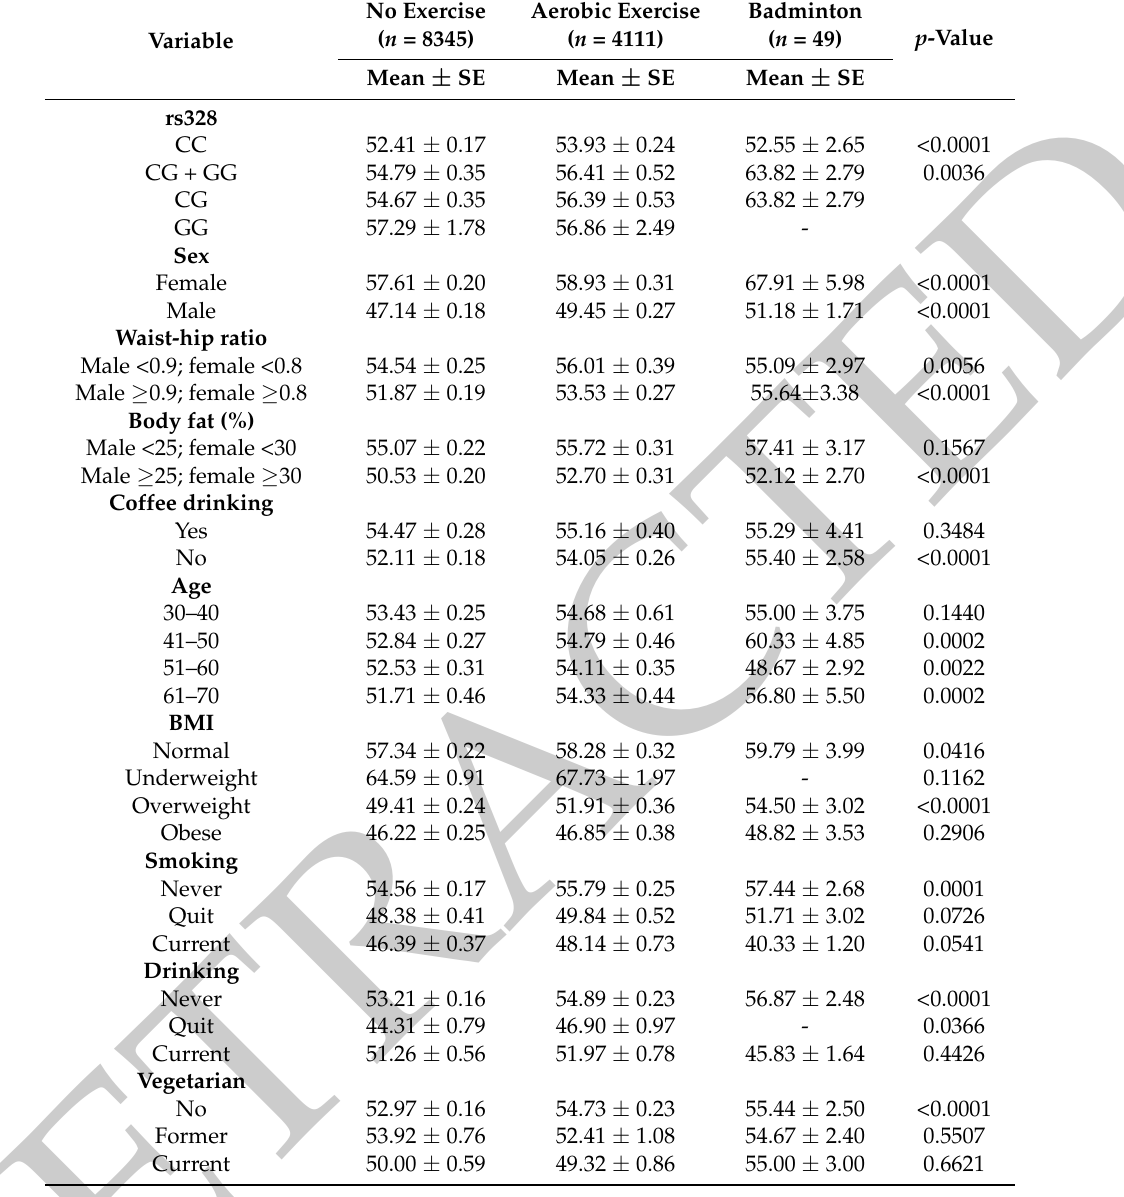
Table 1. Basic characteristics of participants stratified by exercise